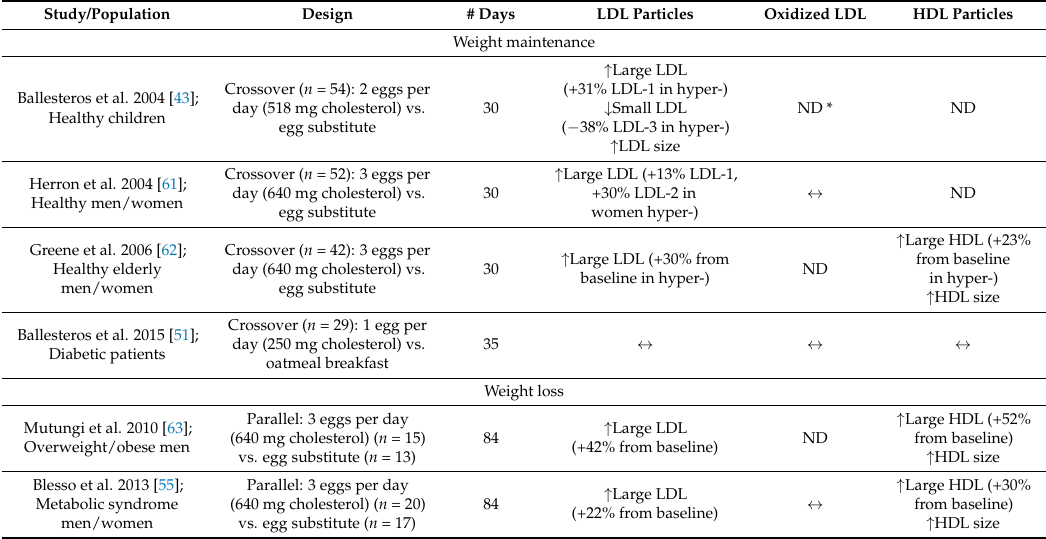
Table 4. Effects of additional dietary cholesterol from egg intake on lipoprotein particle